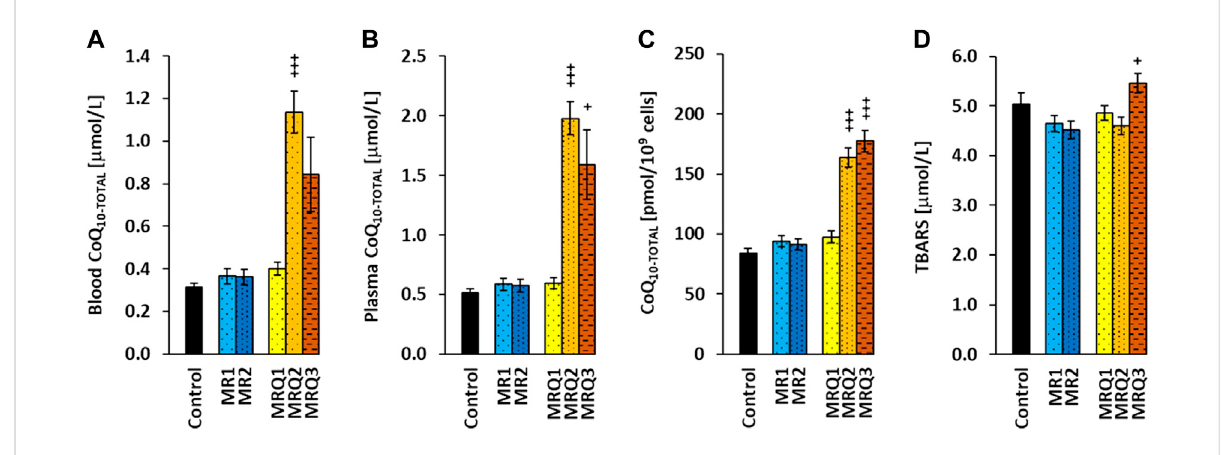
FIGURE 5 TheeffectofmountainsparehabilitationprogramonCoQ 10 concentrationandlipidperoxidationinpatientswithpostC-19.Theconcentration ofcoenzymeQ 10-TOTAL inblood (A) ,plasma (B) ,platelets (C) ,andtheconcentrationofTBARSinplasma (D) ofcontrolsubjectsandpatientswithpost C-19. The groups names as for Figure 3. + p < 0.05, +++ p < 0.001 vs . the same group at the biginning of the